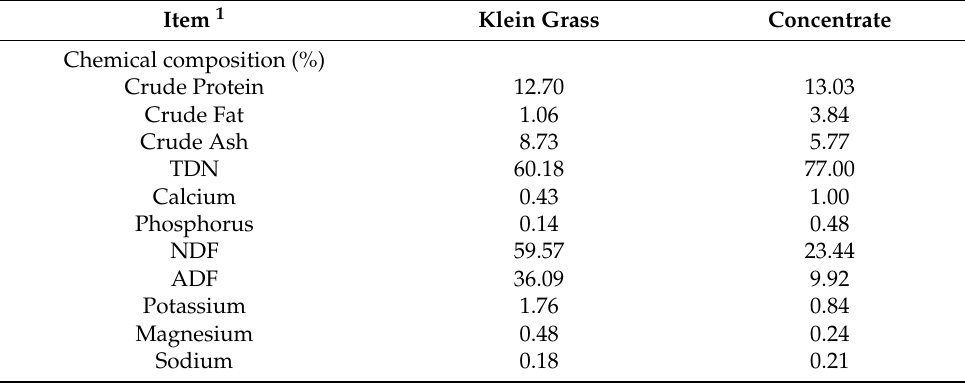
Table 1. Composition of the Klein grass and concentrate on percentage. Item 1 Klein